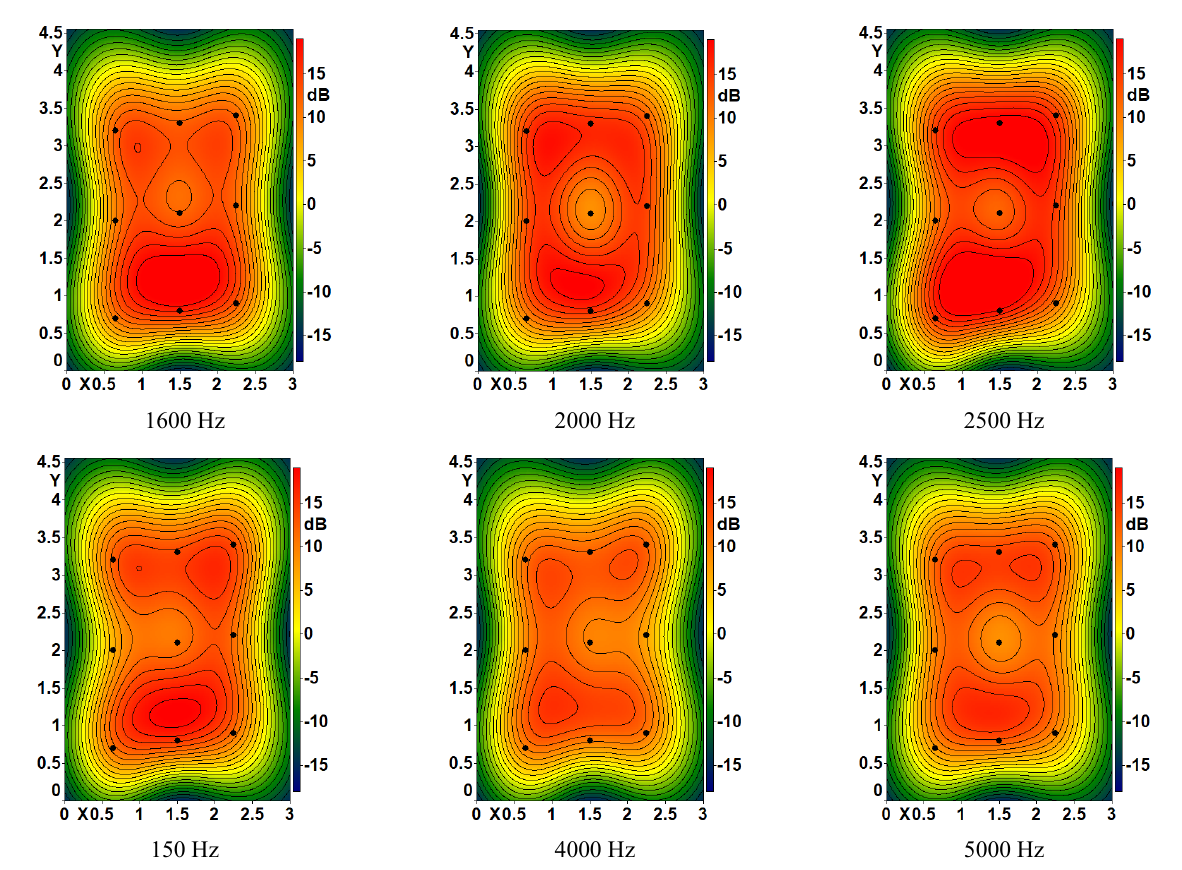
Figure A1. Tapping machine radiation index maps. Average between the three source positions.